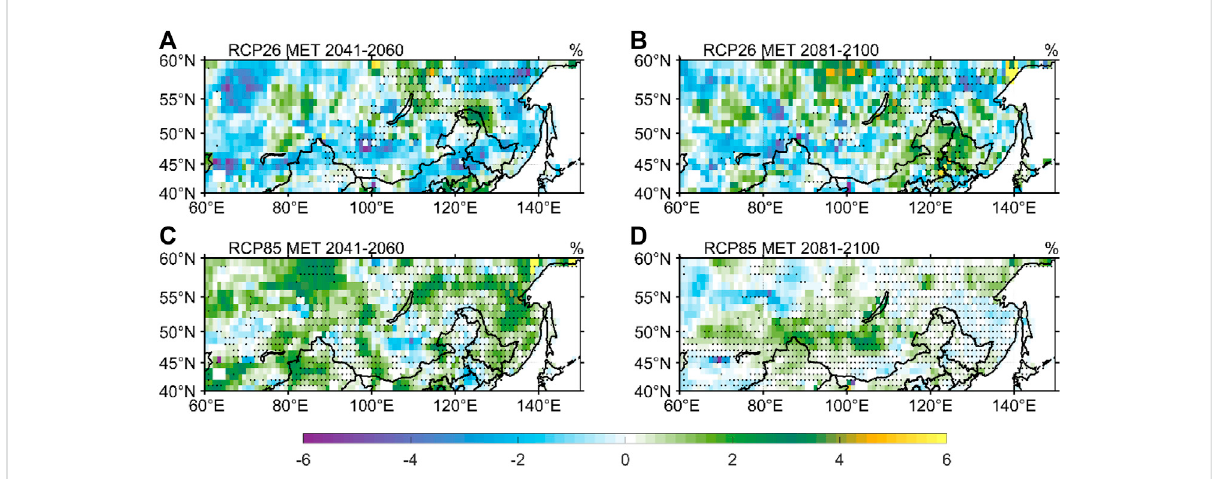
FIGURE 6 Ensemble projected percentage anomalies (%) of EHE-GPP relative to the climatological state during (A,C) the mid-century and (B,D) the end- century under (A,B) RCP2.6 and RCP8.5 (C,D) from the MET simulations. Regions with six out of seven models exceeding the 95% signi fi cance level are dotted.